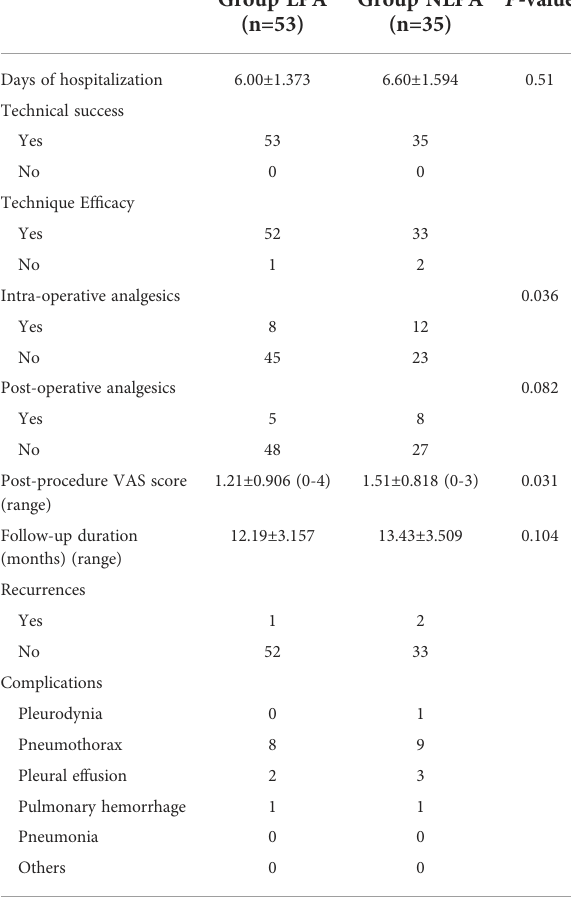
TABLE 4 Ef fi cacy and complications of microwave ablation in the two